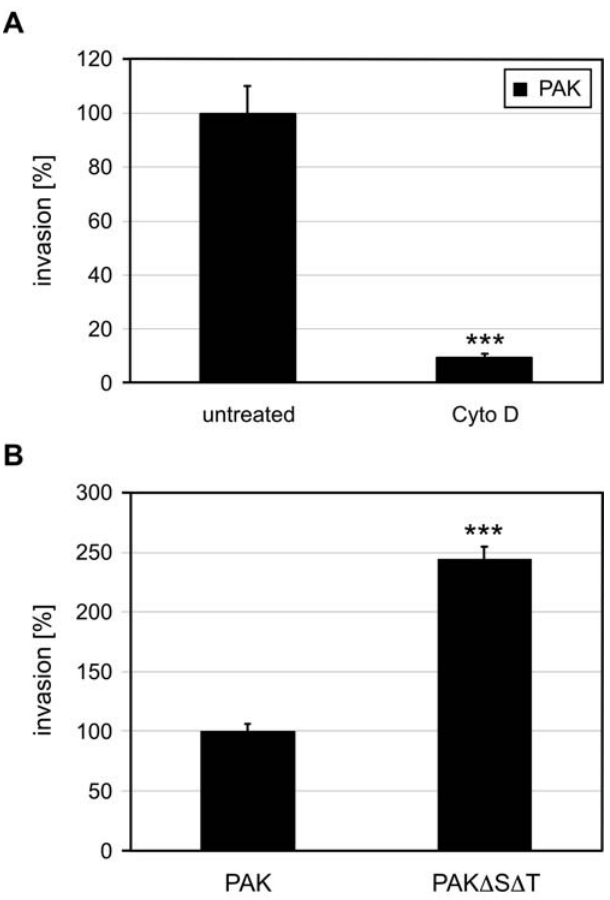
Figure 1. P.aeruginosa entry into Drosophila S2 cells mimics entry into mammalian cells. (A) Invasion of PAK into Drosoph- ila S2 cells is actin-dependent. Drosophila S2 cells were treated with 10 m M Cytochalasin D and infected with PAK for 2 h at 28 u C. The number of internalized bacteria was determined by performing an invasion assay. Results are normalized to untreated cells. ***p , 0.001 compared to untreated cells. (B) The T3SS effector proteins ExoS and ExoT inhibit P.aeruginosa entry into S2 cells. Invasion of PAK and PAK D S D T into S2 cells after 2 h at 28 u C were compared. The results were normalized with respect to invasion of PAK. ***p , 0.001 compared to invasion of PAK into S2 cells. aeruginosa invasion, including Abelson tyrosine kinase (Abl), its target CT10 regulator of Kinase (Crk), and p21-activated kinase (Pak). The identification of multiple components within a pathway indicated that this pathway might be relevant to uptake of P.